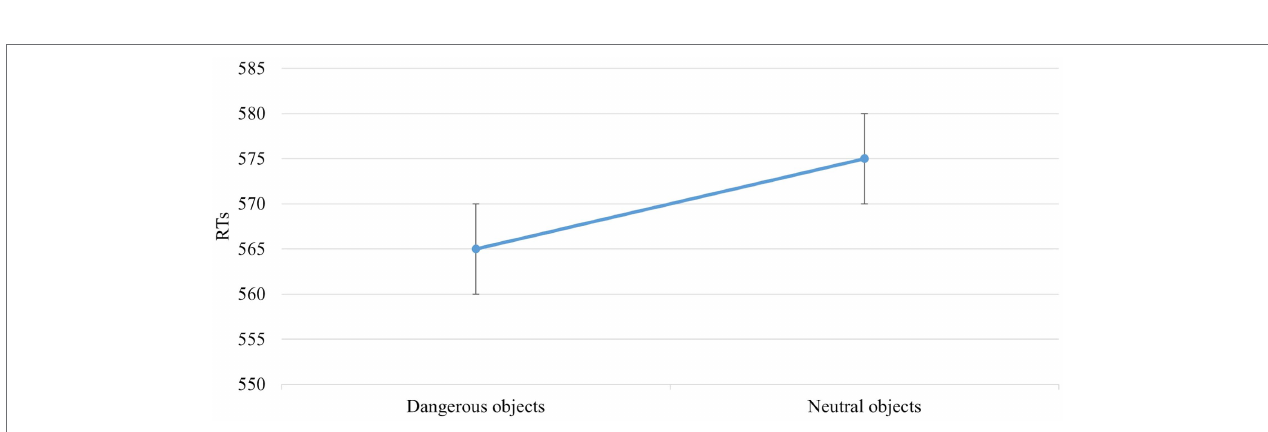
FIGURE 4 | Significant Session effect in the block without IAPS . Values are in milliseconds and bars represent the standard error. “First presentation” indicates that the block without IAPS images is presented before the block with IAPS images, whereas “Second presentation” indicates the opposite situation where the block without IAPS images is presented just after the block with IAPS